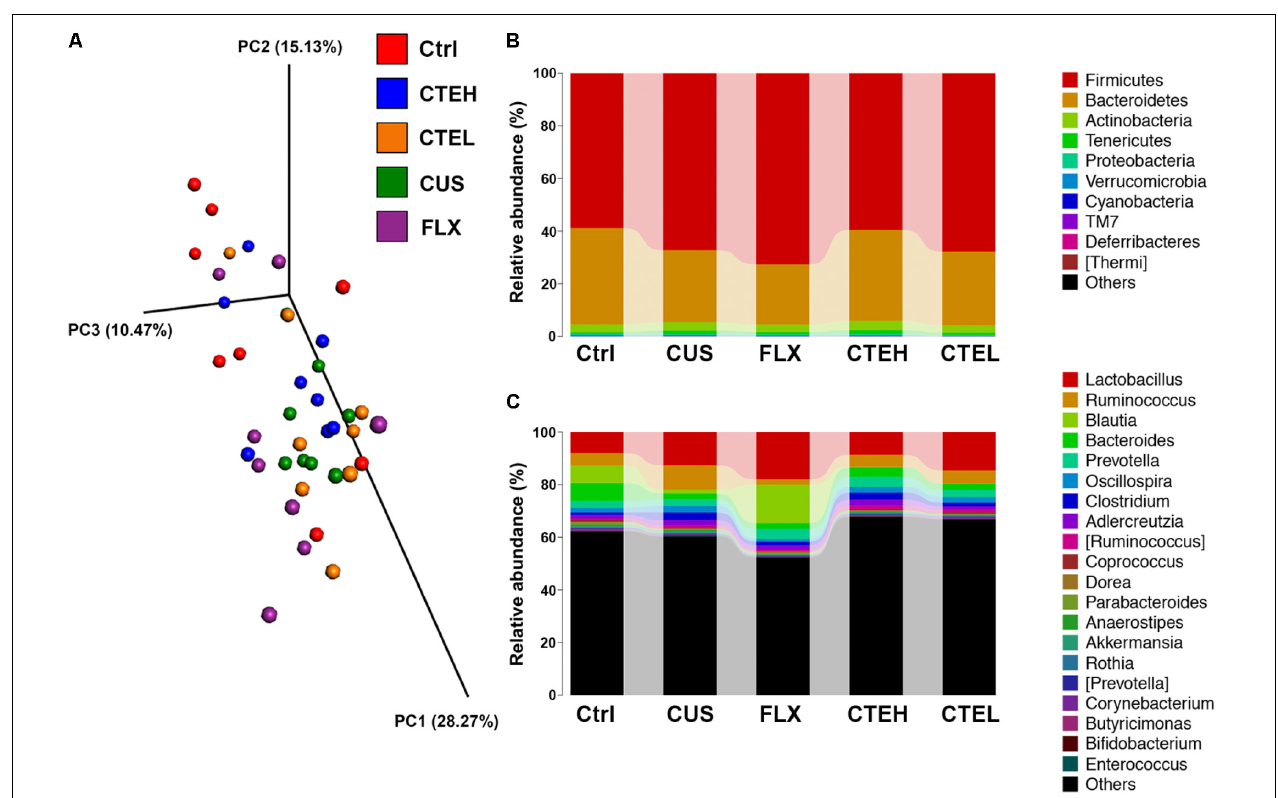
FIGURE 3 | 3D diagram of Weighted UniFrac PCoA of intestinal microbiota extracted from rat fecal samples (A) . Microbial distribution at phylum level (B) . Microbial distribution at genus level (C) . Ctrl, control; CUS, chronic unpredictable stress; FLX, fluoxetine; CTEH, C. tubulosa extract high dose; CTEL, C. tubulosa extract low